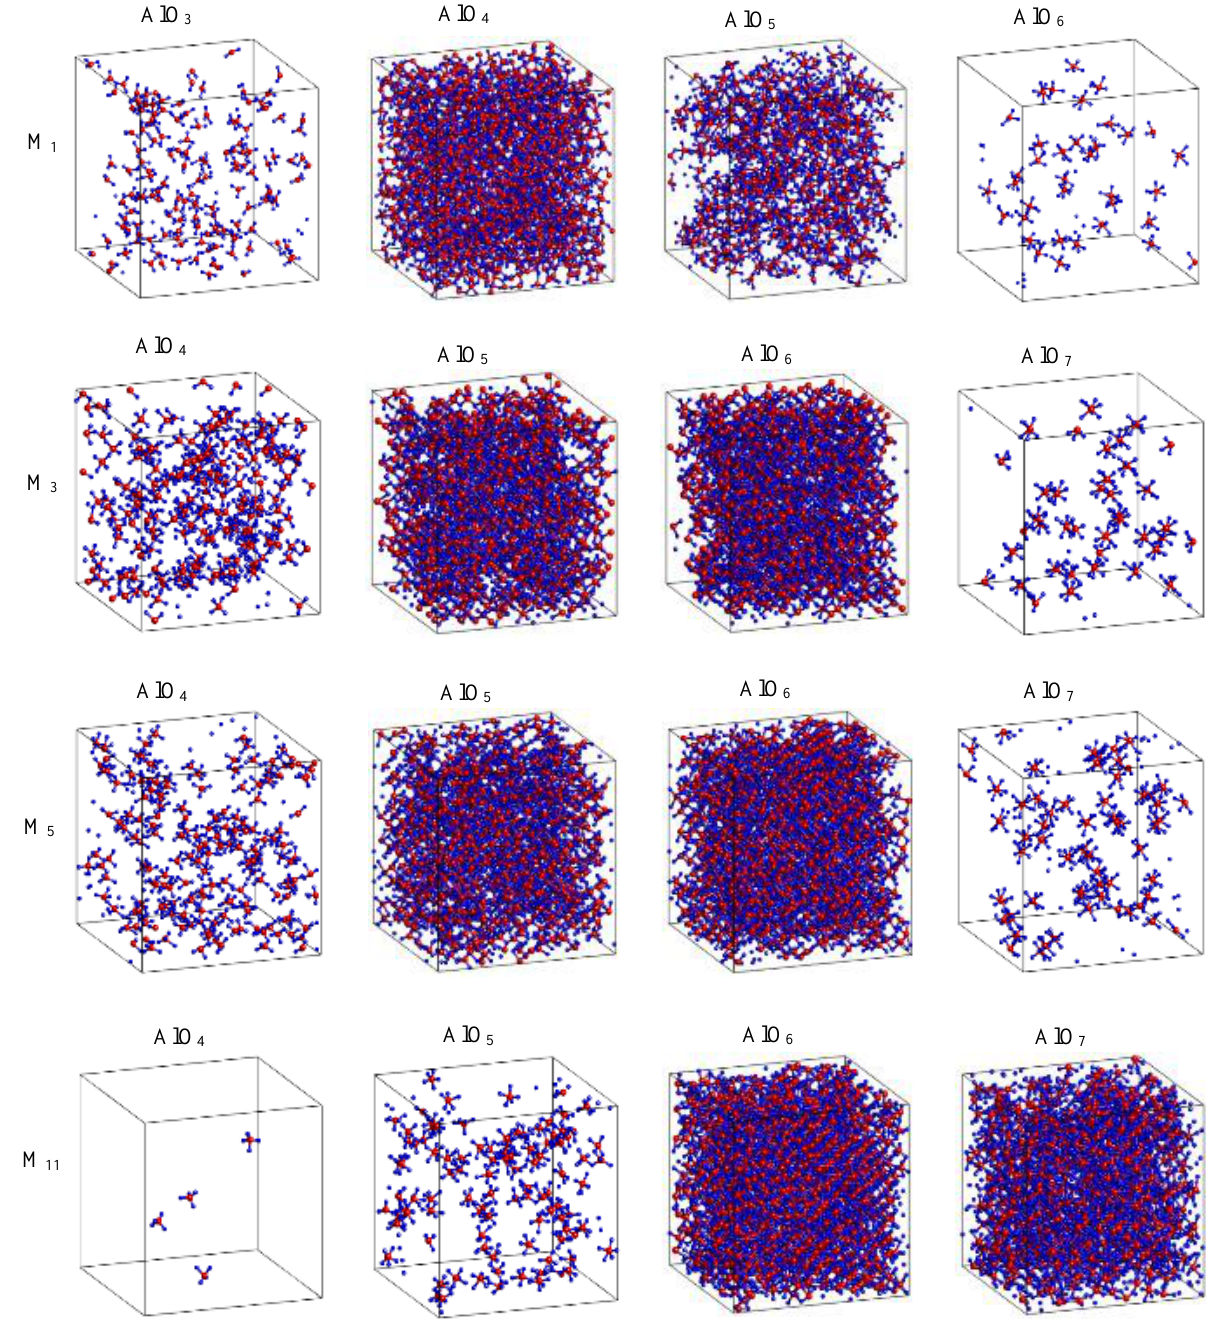
Figure 8. Spatial distribution of AlO 3 , AlO 4 , AlO 5 , AlO 6 and AlO 7 in the liquid Al 2 O 3 at different pressure and 3500 K. Al and O atoms are in red and blue color,